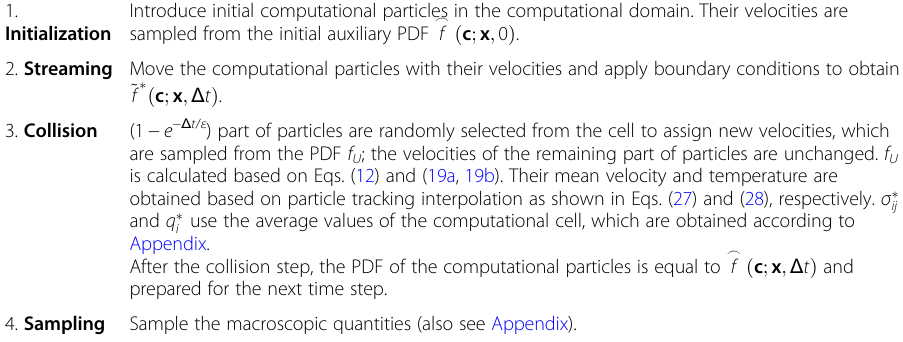
Table 1 Outline of the efficient algorithm of the USP-BGK